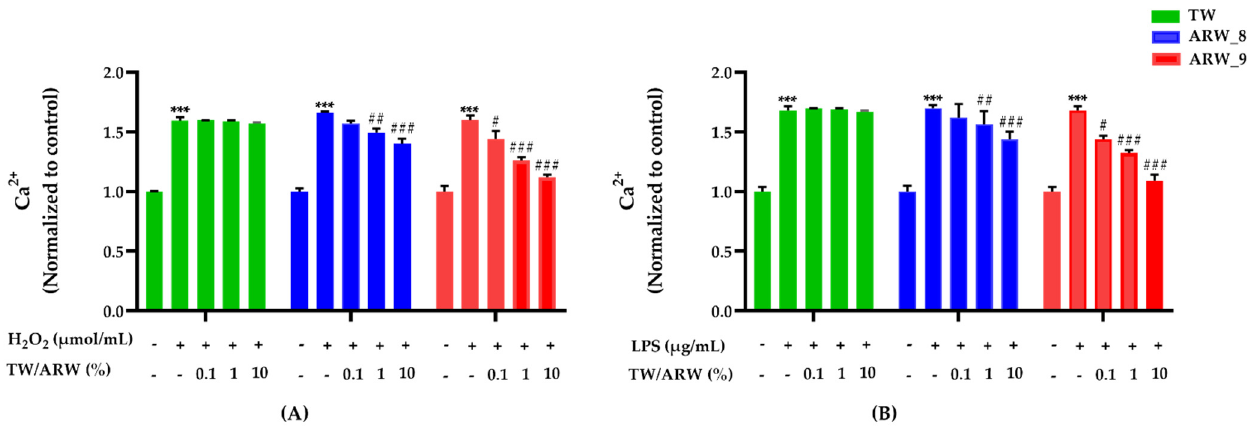
Figure 4. Effect of ARW_8.5 and ARW_9.5 on intracellular Ca 2+ levels in H 2 O 2 − and LPS-induced RAW 264.7 murine macrophage cells. Cytotoxicity was induced by H 2 O 2 (200 µmol/mL for 2 h) ( A ) and LPS (10 µg/mL for 24 h) ( B ), and the cells were treated with ARW (pH 8.5 and pH 9.5) at concentrations of 0.1%, 1%, and 10%. Data are expressed as the mean ± standard error of the mean (SEM) of the fold change relative to the control ( n = 3). Statistical significance was analyzed with two-way ANOVA. ( − ): non-treatment, (+): treatment. ***, p < 0.001 vs. normal control. # , p < 0.05; ## , p < 0.01, and ### , p < 0.001 vs. Con/H 2 O 2 or Con/LPS. Abbreviations: ARW, alkaline reduced water; TW, tap water; H 2 O 2 , hydrogen peroxide; LPS, lipopolysaccharide; Ca 2+ , intracellular calcium; Con, control